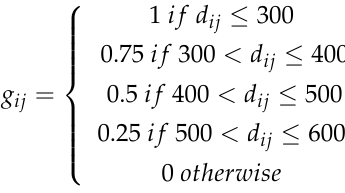
Table 5. Parameter values for the test